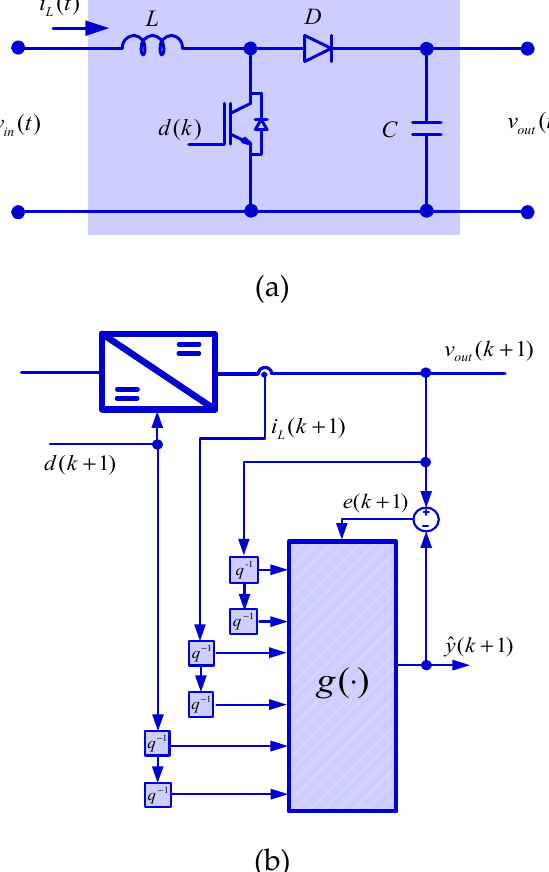
Figure 2. ( a ) Standalone DC-DC boost converter circuit; and ( b ) the identification framework using the LMN.